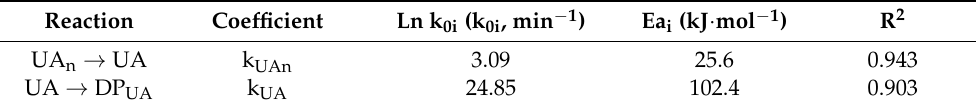
Table 8. Results calculated for the parameters governing the reactions of uronyl groups and the derived products.